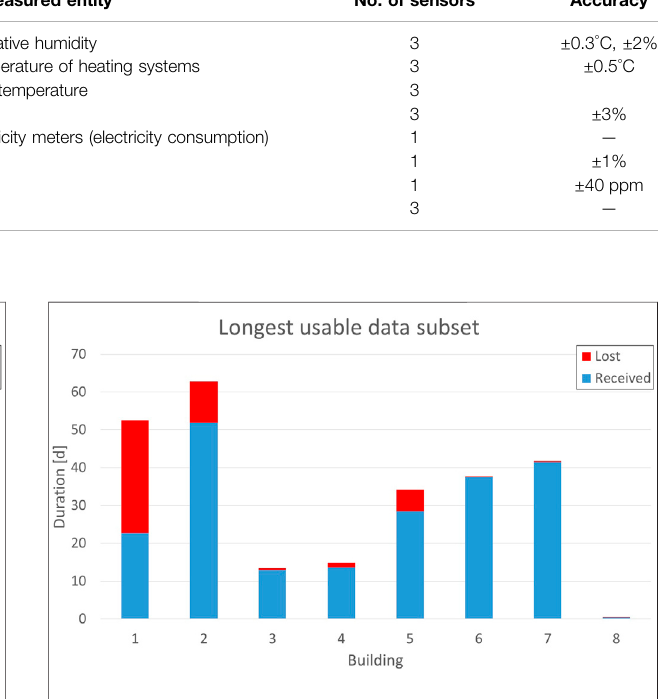
FIGURE2| Lostandreceiveddataoftheentiremeasurementcampaign in days for each building.